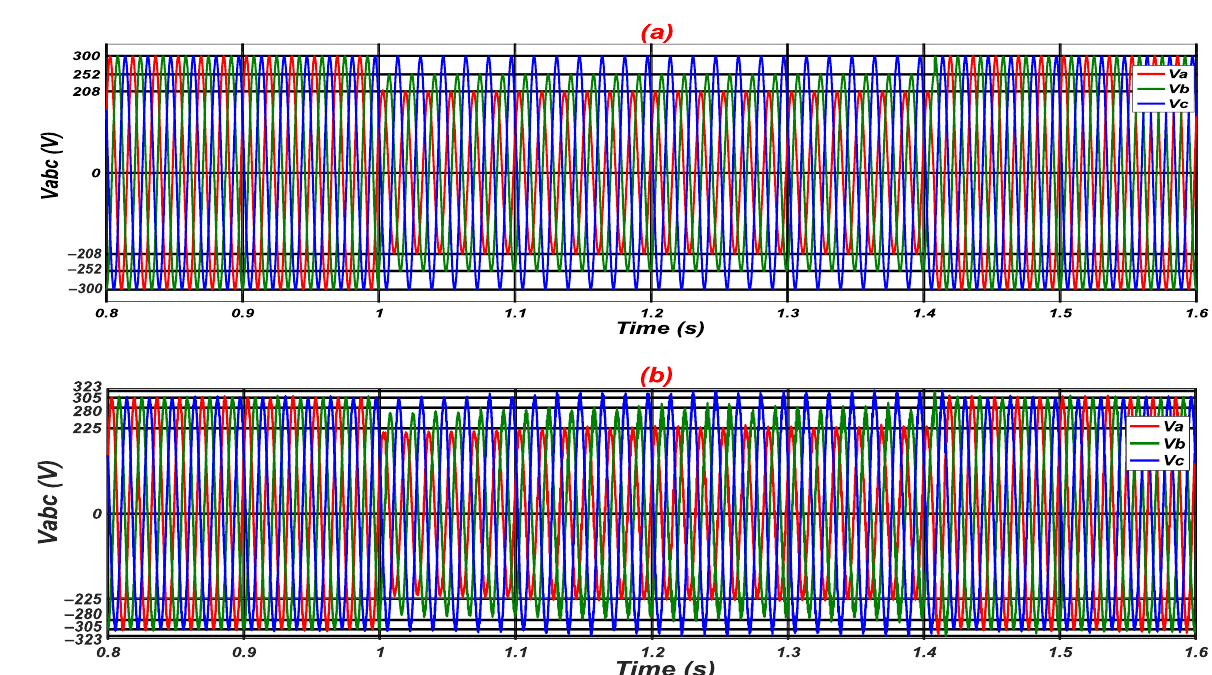
Figure 10. Phase voltages at B_12: ( a ) Fault at phase B without GCPVS operation, ( b ) Fault at phase B with GCPVS operation.